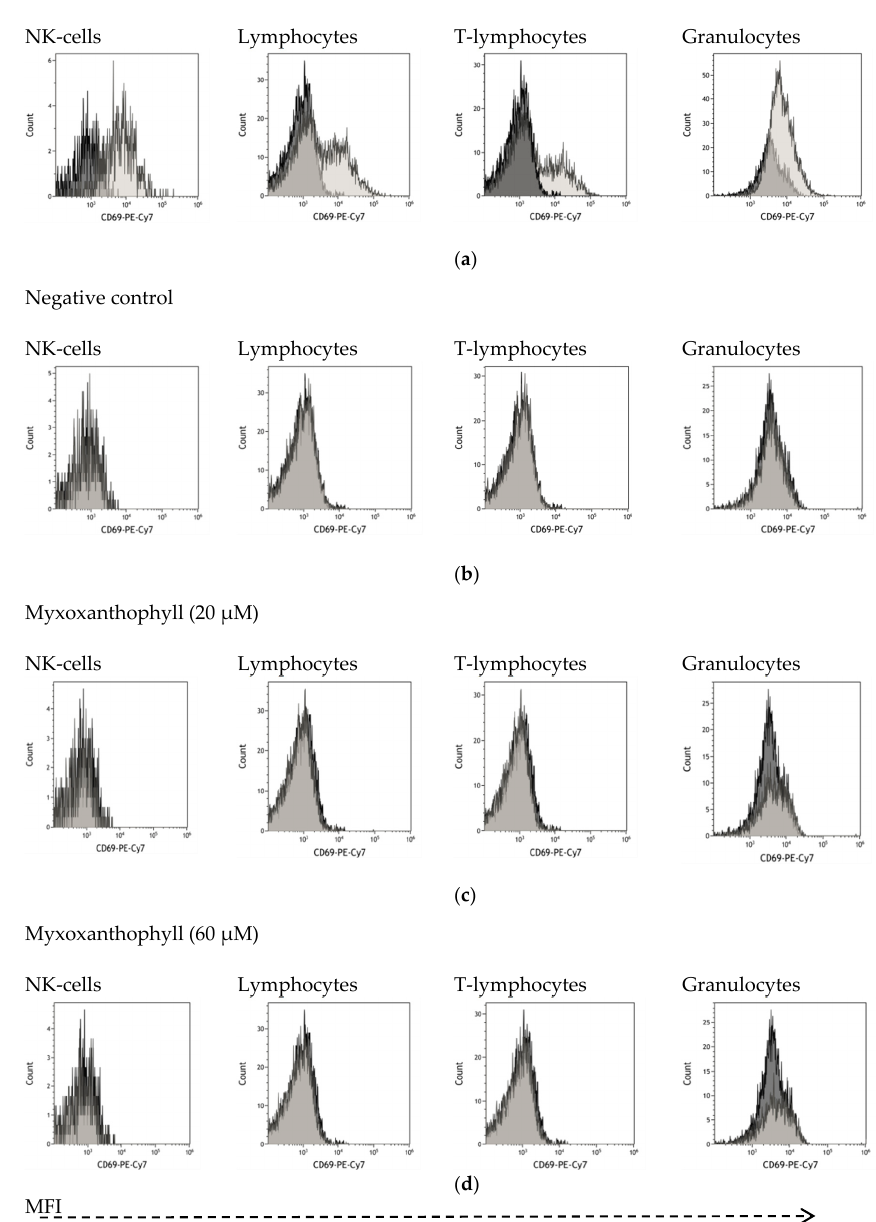
Figure 8. Mean fluorescent intensity (MFI) of CD69 expression on activated immune cells from human peripheral blood in response to treatment with myxoxanthophyll for 24 h is shown as histograms. The filled histograms (dark grey) represent the group control (untreated) and the other histograms (light grey) the stimulated (pretreated) group. The mitogen phytohemagglutinin (PHA) was used as a positive control, showing the activation of immune cells ( a ). In negative control, the cells were treated neither with myxoxanthophyll nor PHA, and no immune cell activation was observed ( b ). Granulocytes were activated by myxoxanthophyll at 20 µ M ( c ) and 60 µ M ( d ). The histograms are representative of three separate experiments using cells from three di ff erent healthy